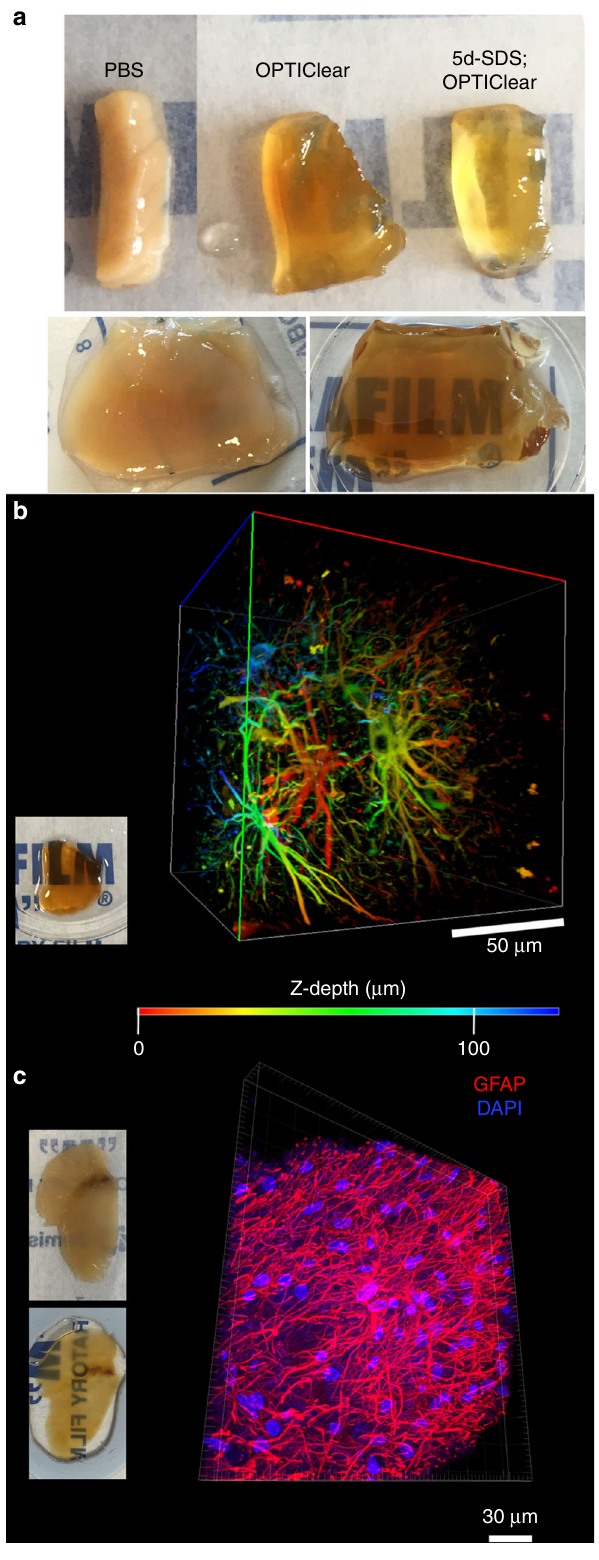
Fig. 1 Immuno fl uorescence staining of archival brain tissues. a Upper panel: comparison of formalin- fi xed human cerebellar tissue immersed in PBS (left), OPTIClear (middle) and OPTIClear after 5 days of SDS delipidation at 55 °C (right). Lower panel: comparison of 5 mm-thick, formalin- fi xed human striatum tissue block after 3.5 months of SDS delipidation at 55 °C, before (left) and (after) OPTIClearing. b Colour depth-coded, Z -stack image of a block of 2 mm-thick cingulate cortex that has been formalin- fi xed for 50 years, stained with antibodies against GFAP with an imaging depth of 125.57 µ m. The tissue was cleared after SDS treatment for 4 months at 55 °C and cleared in OPTIClear. Scale bar = 50 µ m. c Z -stack image of a piece of formalin- fi xed, paraf fi n-embedded midbrain tissue immunostained for GFAP (red) and counterstained with DAPI (blue) after dewaxing and rehydration ( Z -stack depth = 20.77 µ